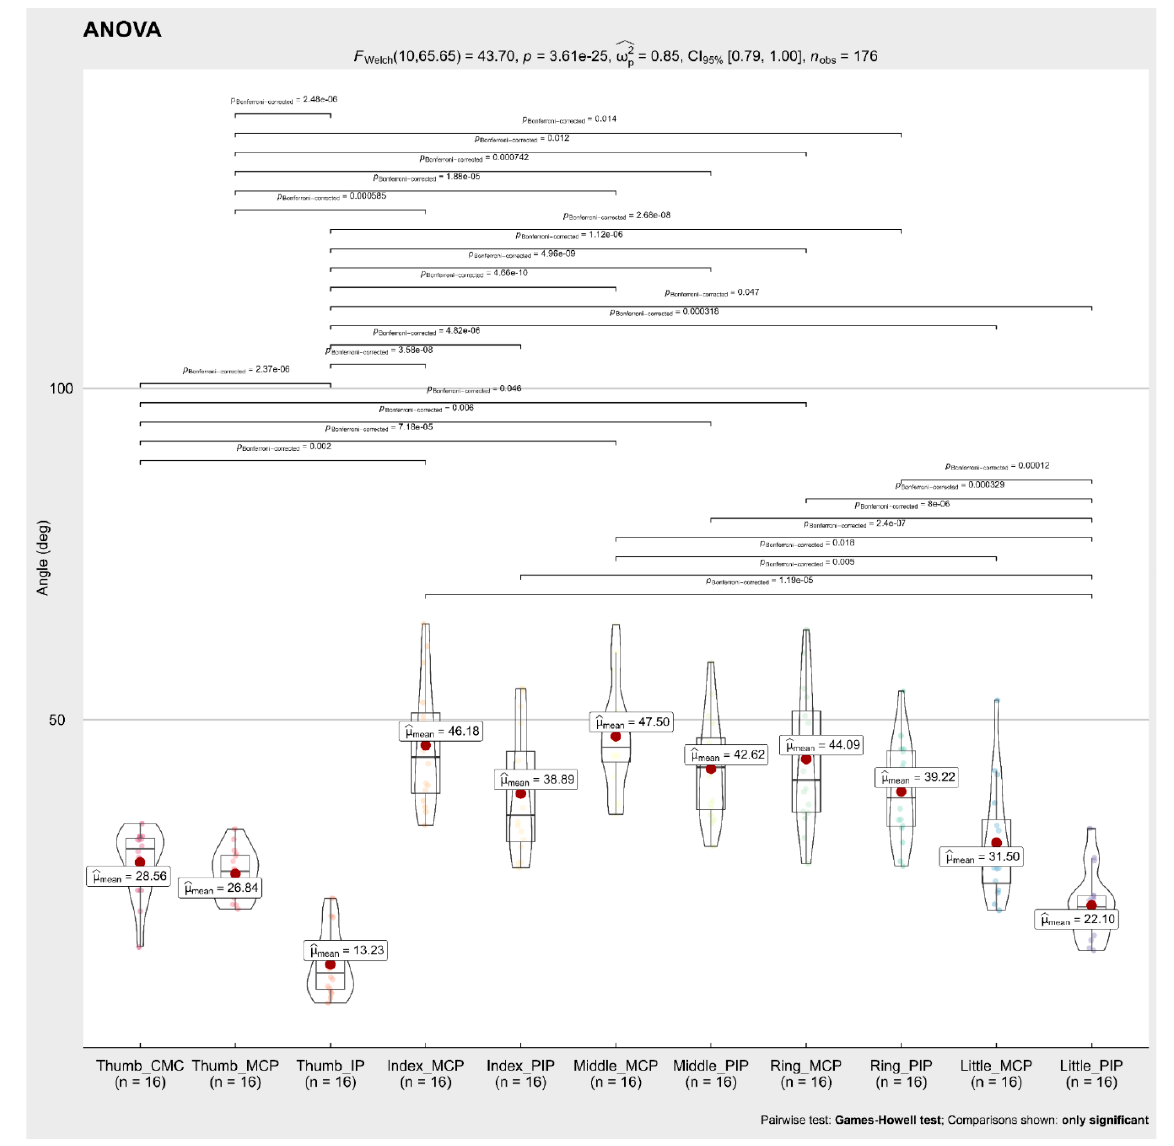
Figure 7. Welch’s ANOVA and Post hoc results; Comparison flexion angles concerning the finger joints, during the 16 tests of the ARAT; Horizontal lines indicate significant differences ( p < 0.05, Games–Howell test post hoc comparison). The flexion angles of the carpometacarpal (CMC), metacarpophalangeal (MCP), and interphalangeal (IP) joints of the Thumb finger were significantly smaller ( p > 0.05 each) than the flexion angles of the MCP joints of the Index, Middle, Ring. Similarly, the flexion angles of the proximal interphalangeal (PIP) joint of the Little finger were significantly smaller ( p > 0.05 each) than the flexion angles of the MCP and PIP joints of the Index, Middle, and Ring fingers. deg = degrees.